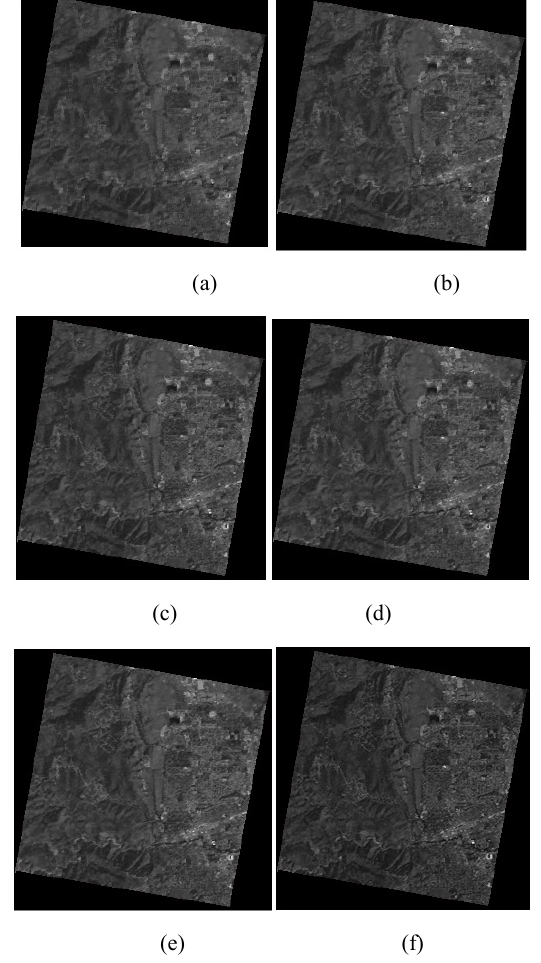
(2) Comparison with different interpolation method To validate the accuracy of proposed interpolation method, nearest neighbour interpolation, bilinear interpolation, and CCI algorithms are executed based on MATLAB. The interpolation images of nearest neighbour interpolation, and bilinear interpolation are shown in Figure 13. Through the visual check Figure 13 and 12, it can be found that the result of CCI interpolation georeferenced image has the enough smoothness and visual effect is better than that of the bilinear interpolation and nearest neighbour interpolation. However, the CCI algorithm consumes more Figure 11. The raw image